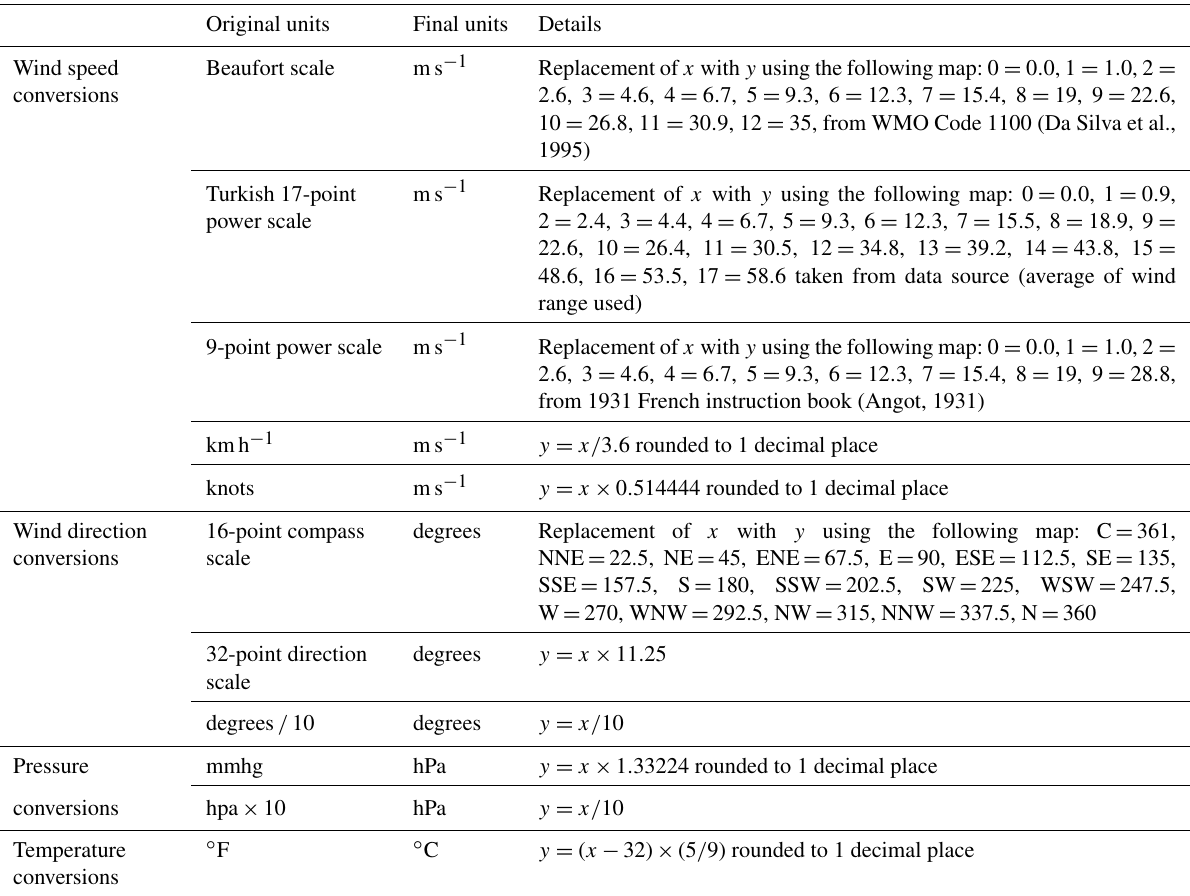
Table 2. List of conversions applied to digitised data, where x represents the original unit and y is the converted value. Full details of the conversion applied to data from each station is given in Table